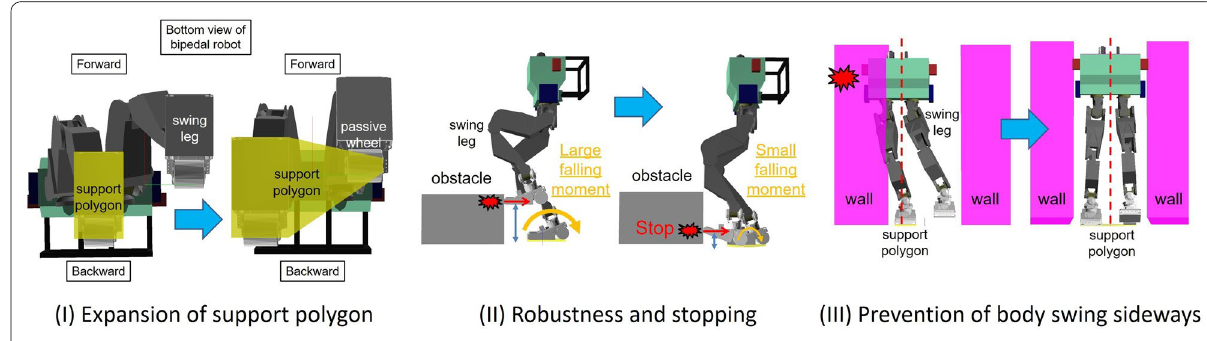
Fig. 2 Key features and contribution of locomotion without swing